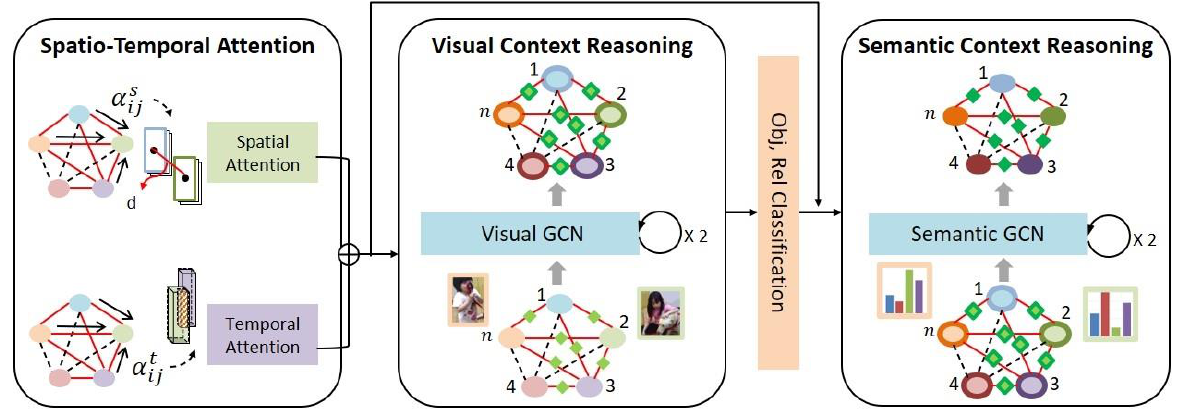
Figure 4. Context reasoning (CR).